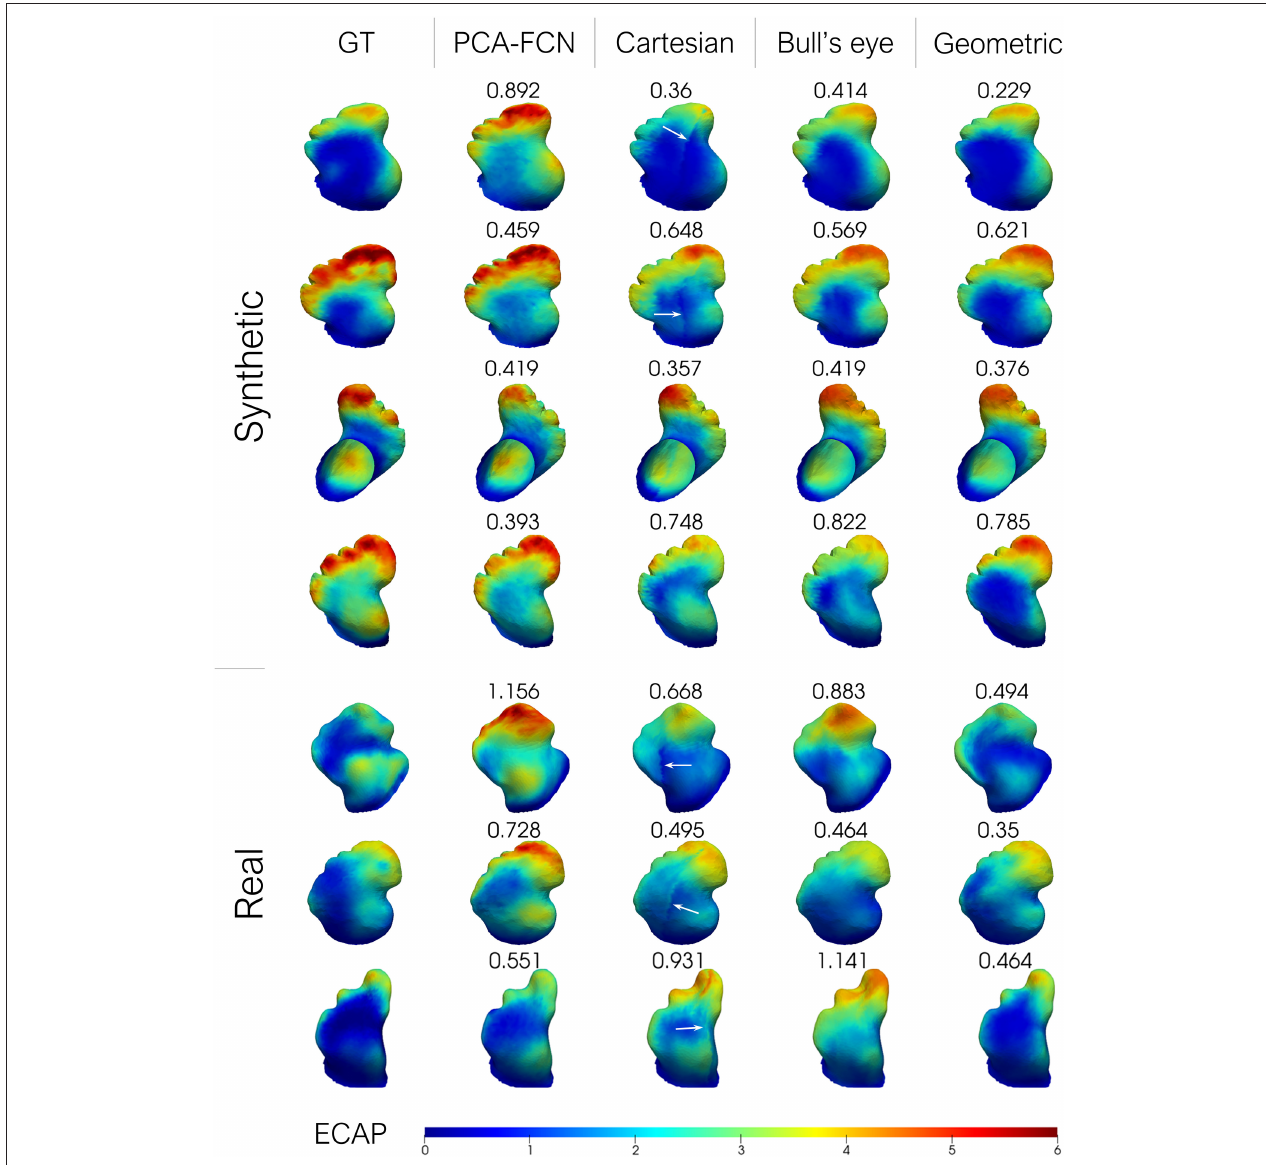
FIGURE 5 | From left to right: ground-truth endothelial cell activation potential (ECAP) from fluid simulations; principal component analysis model (PCA-FCN) prediction; Cartesian grid and Bull’s eye plot prediction; geometric deep learning prediction (Geometric). The mean absolute error (MAE) is also provided alongside. Higher ECAP values (in red) are linked to a higher risk of thrombus